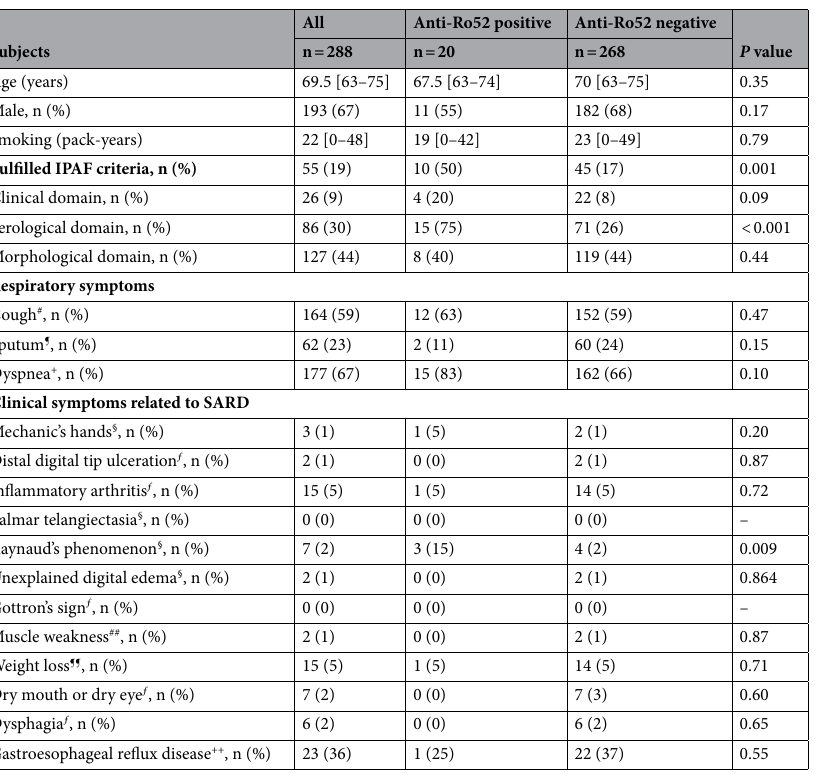
Table 3. Clinical characteristics of patients in the presence or absence of anti-Ro52/tripartite motif-containing 21 antibodies (anti-Ro52). Data presented as median [interquartile range] or frequencies (%). n = 288, unless otherwise stated; # n = 276; ¶ n = 273; + n = 263; § n = 285; ƒ n = 286; ## n = 287; ¶¶ n = 282; ++ n = 64. Ro52: Ro52/ tripartite motif-containing 21; IPAF: interstitial pneumonia with autoimmune features; SARD: systemic autoimmune rheumatic diseases. P value: anti-Ro52 positive vs. anti-Ro52